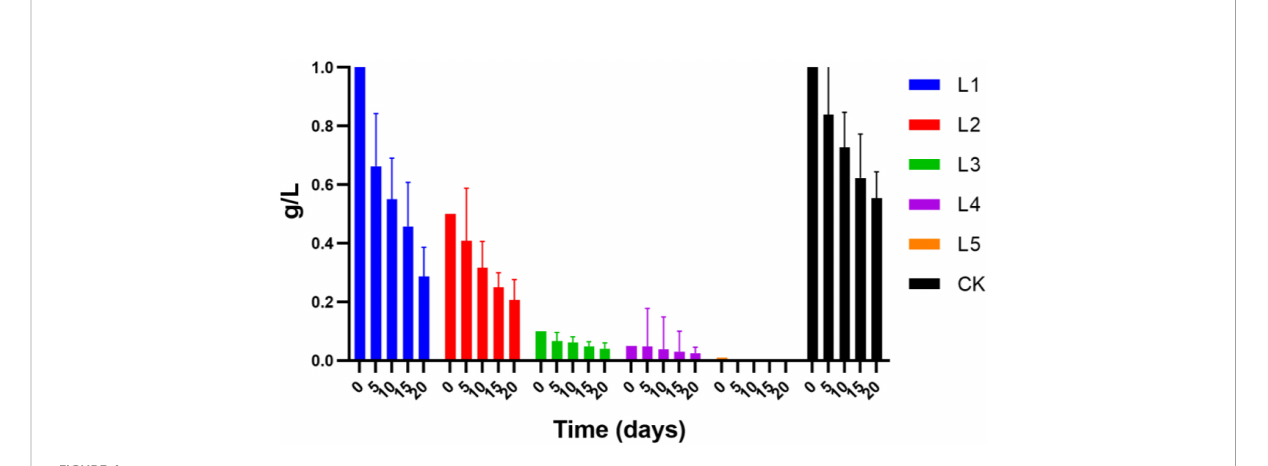
FIGURE 4 Various concentrations of streptomycin removal by duckweed